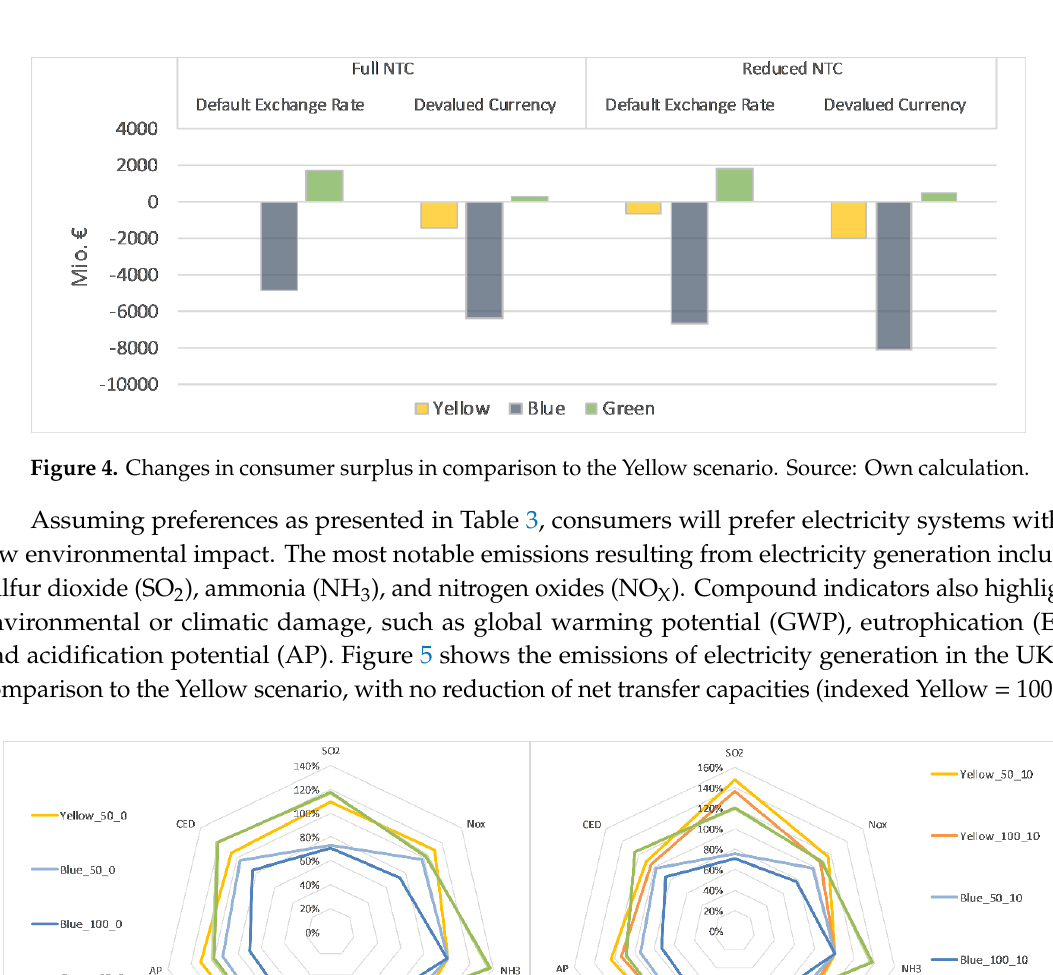
Table 6. Average price spread in € per MWh . Source: Own calculation.